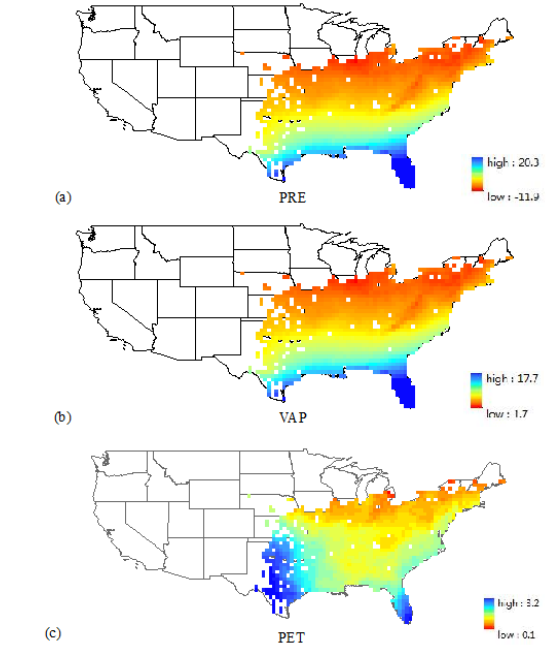
Figure 1. The maps illustrate the start locations of the survey routes (2014) for (a) Carolina wren, (b) Red-bellied woodpecker, and (c) Cerulean warbler.